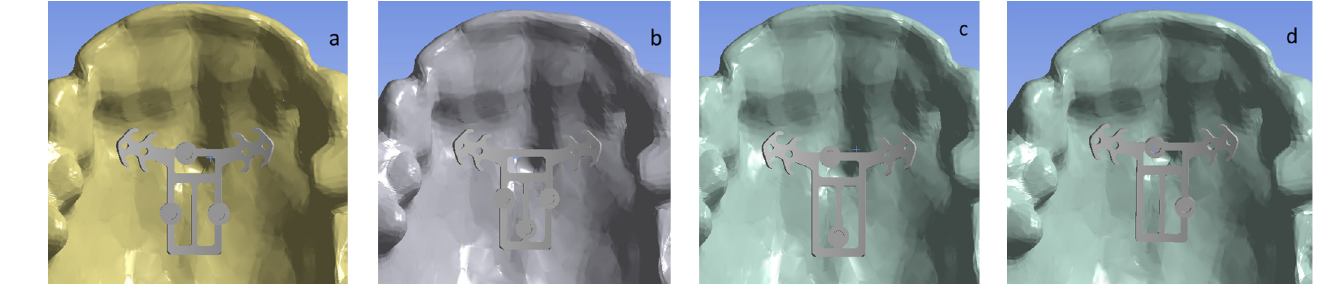
Figure 1. 3D solid geometrical models: ( a ) two types of jawbone tissue, transparent—cortical bone, yellow—trabecular bone; ( b ) implant of the first configuration (Model 1).